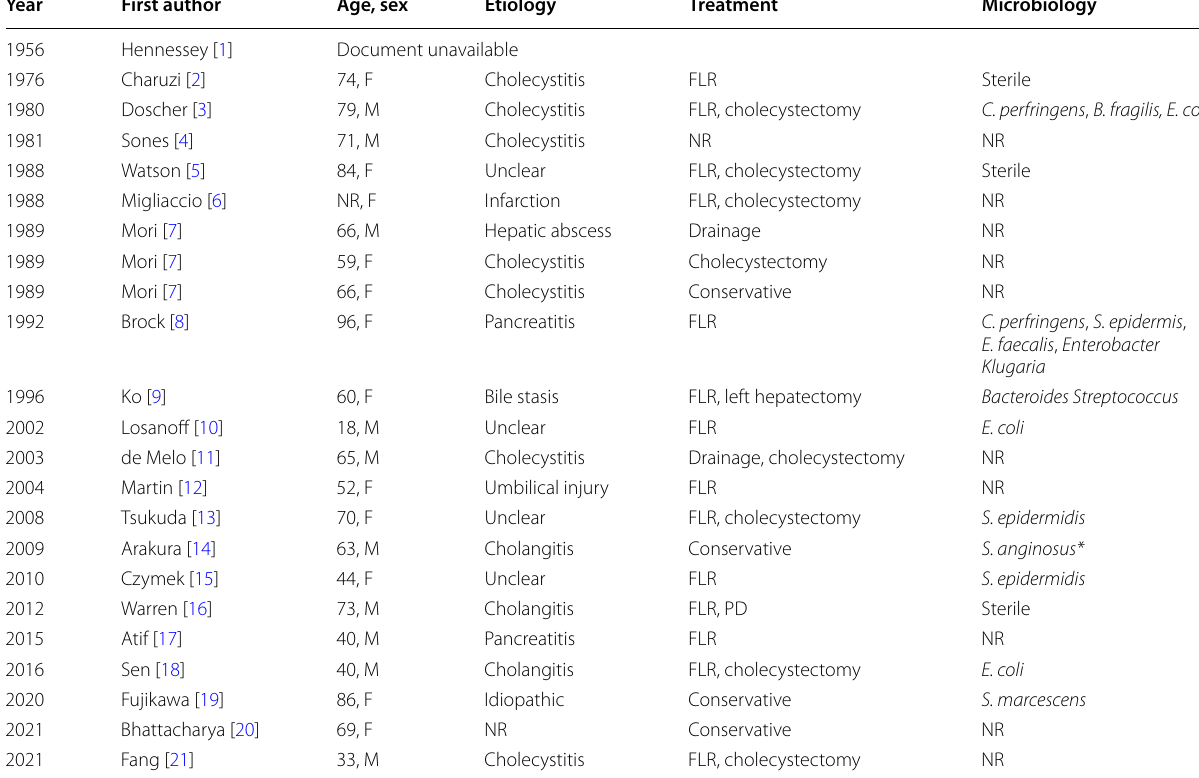
Table 1 Reported cases of falciform ligament